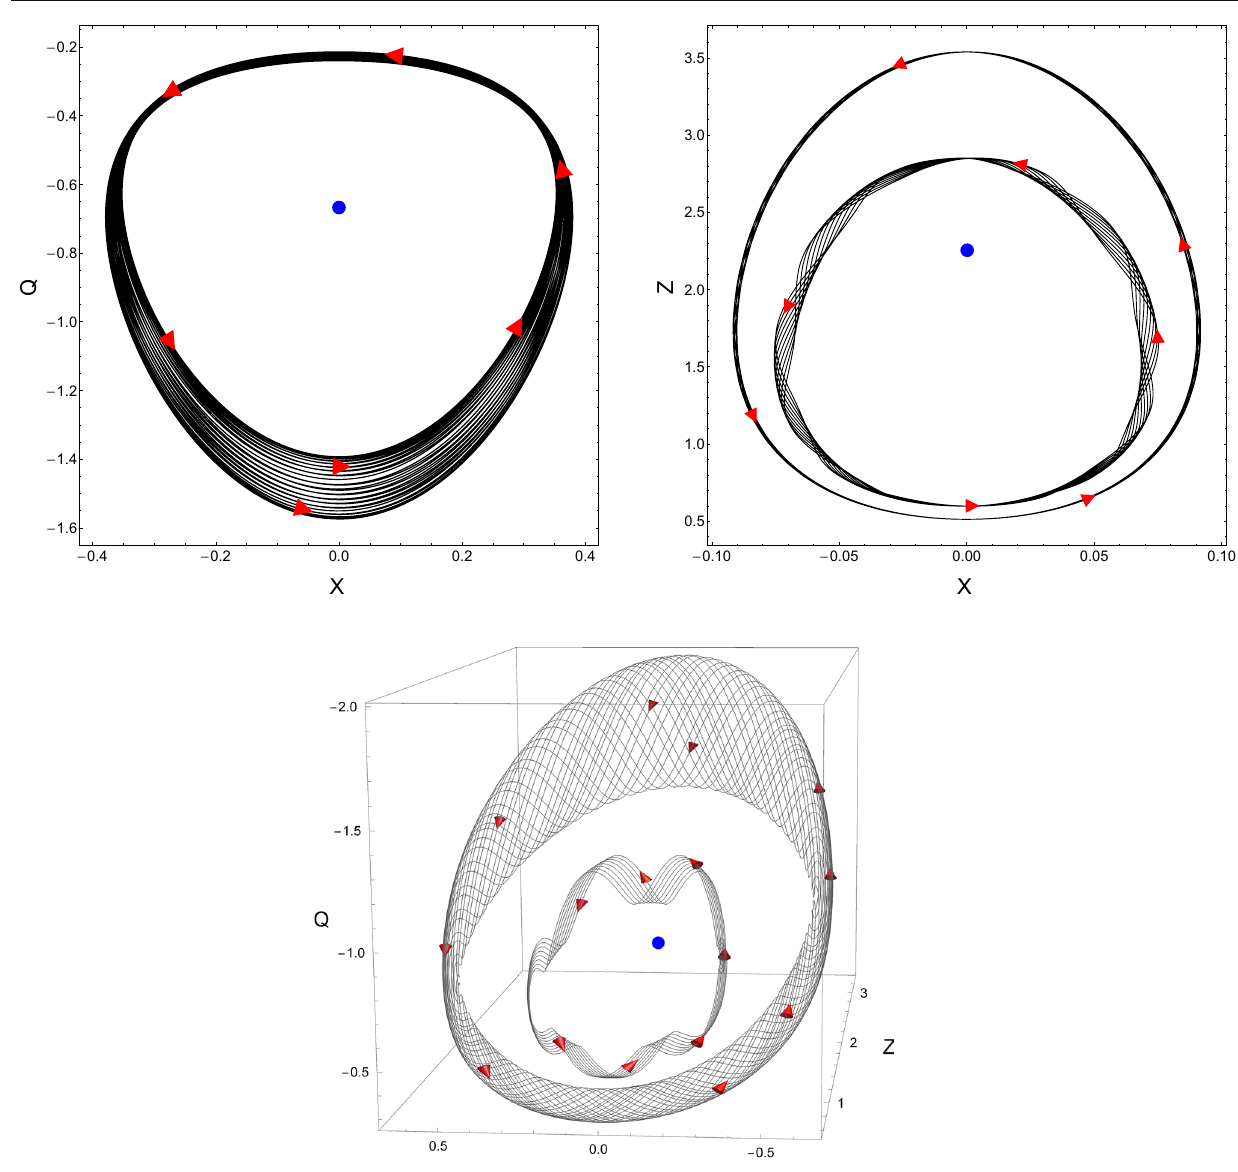
Fig. 4 Dynamical evolution of the Universe dominated by a stiff fluid (γ = 2 ) . The initial values for numerical integration of the system (49)–(52) along with model parameters have been set as, ω = − 2 . 6, r = − 4 . 5, X 0 = Y 0 = 0, Z 0 = 1 . 156, Q 0 = − 0 . 214 (left panel) and Z 0 = 3 . 539, Q 0 = − 1 . 7087 for outer orbits and Z 0 = 2 . 8511, Q 0 = − 1 . 3890 for inner orbits of the right panel. The location of fixed